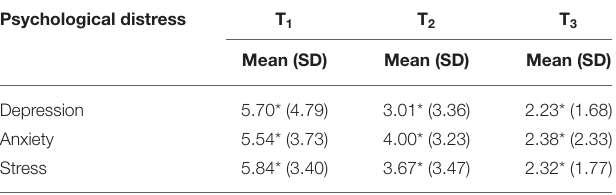
TABLE 3 | Means and standard deviations for psychological distress at pre-intervention, post-intervention, and 1-month